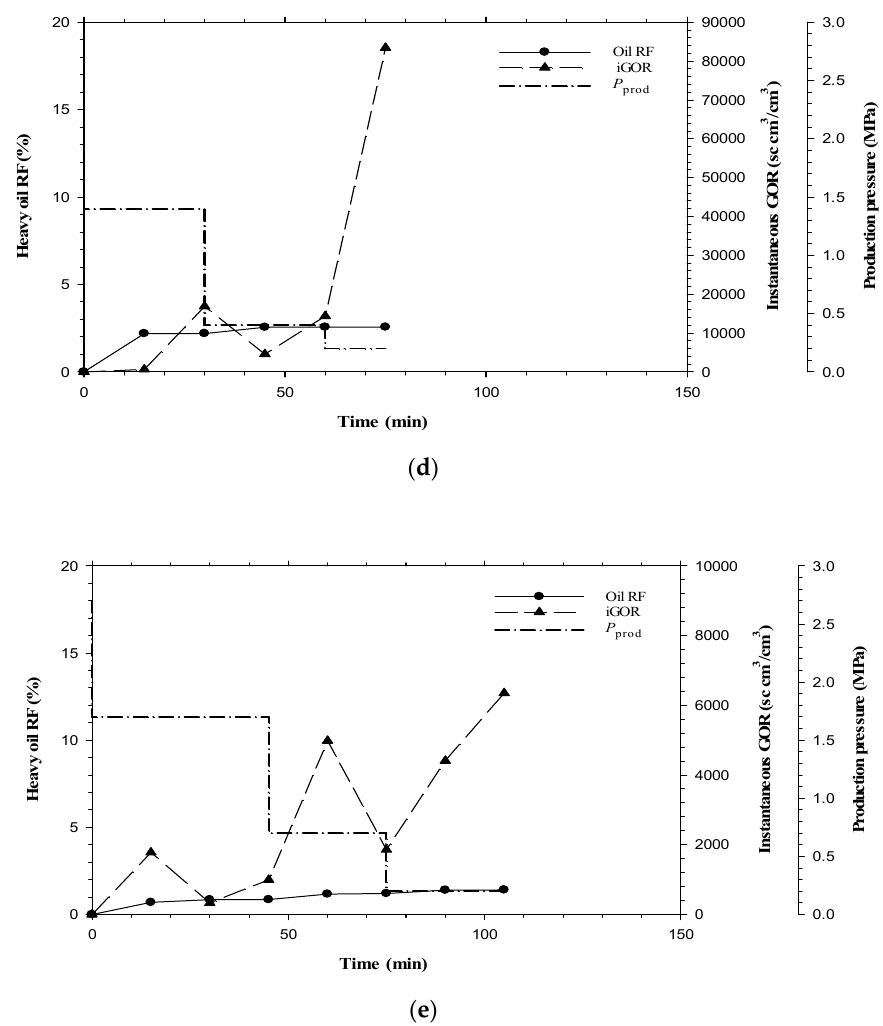
Figure 9. Measured heavy oil recovery factors (RFs), instantaneous gas-oil ratios (iGORs), and production pressures ( P prod ) in SA-GPC process at ∆ P EOR = 1.0 MPa (Test #8) ( a ) Cycle #1; ( b ) Cycle #2; ( c ) Cycle #3; ( d ) Cycle #4; and ( e ) Cycle #5.